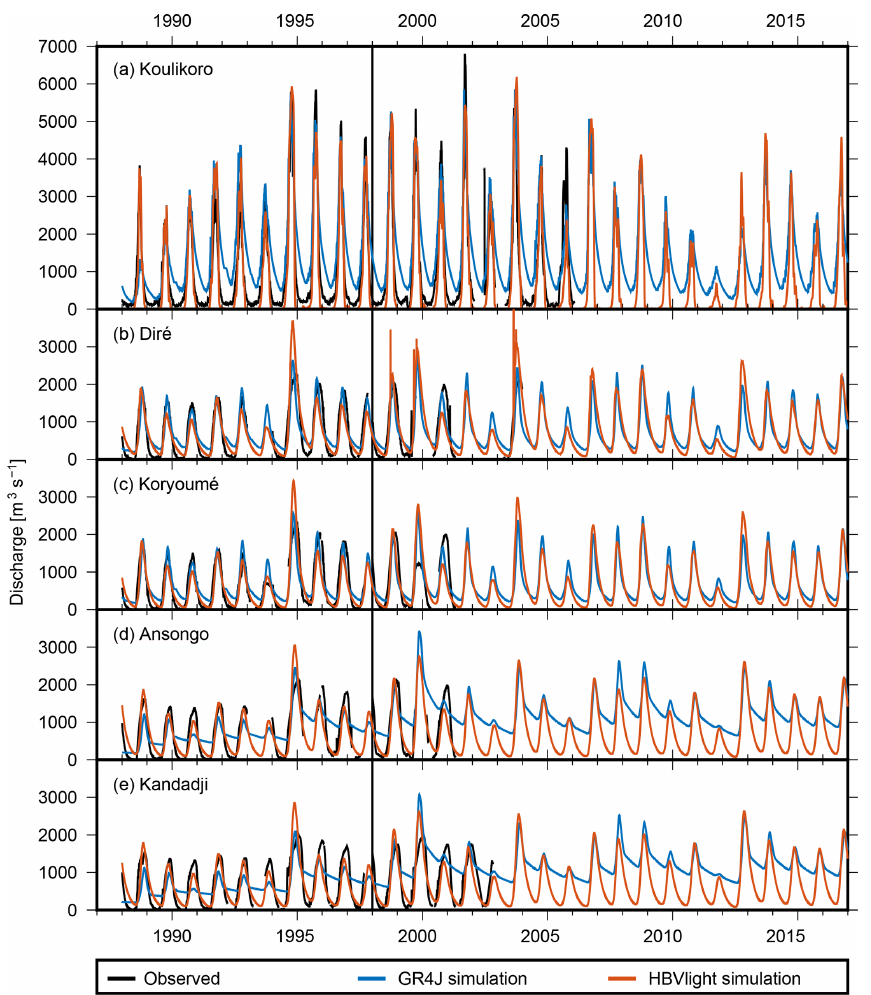
Figure 5. Observed and simulated discharge for the five Niger stations. The first 10 years of data serve as calibration period, marked by the vertical black line. The validation period starts after these 10 years.